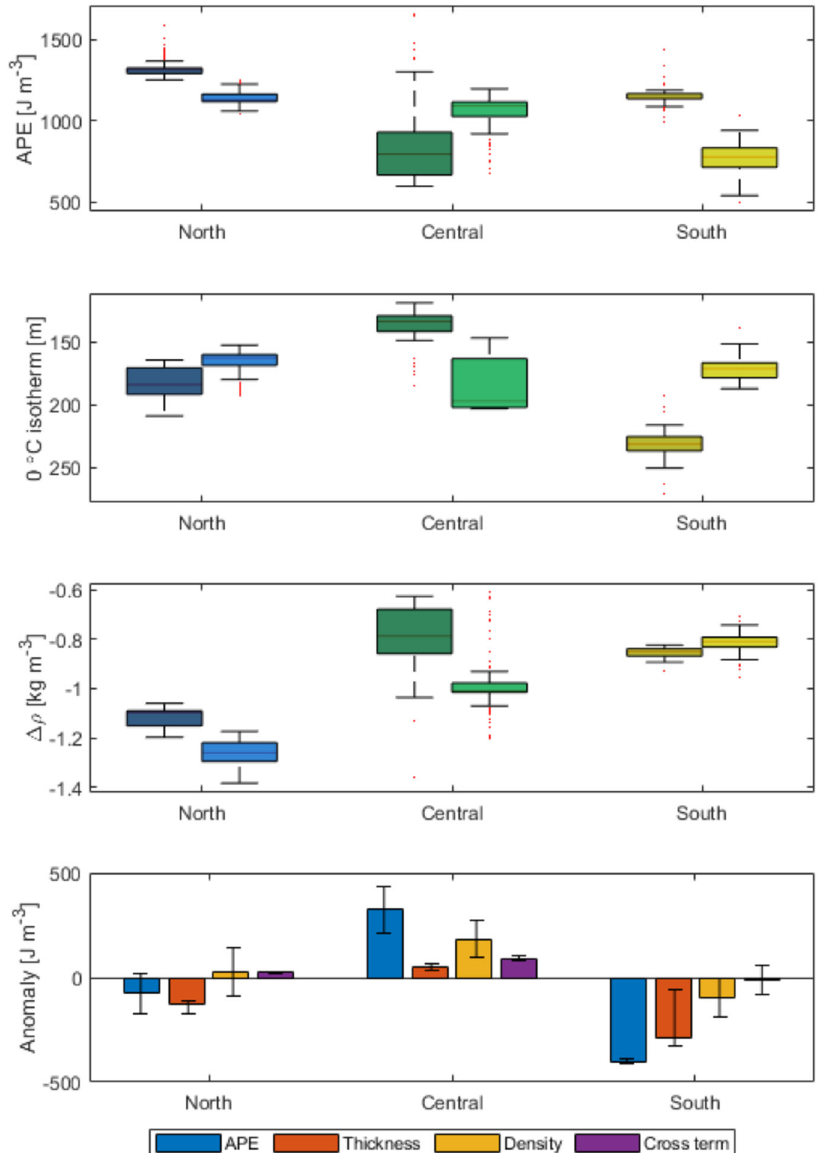
Fig. 5| Changesin Available PotentialEnergyanditsconstituents duringJuly/ August/September. Available potential energy (APE, a ), depth of the 0°C iso- therm ( b ) and mean density deviation ( Δρ ) from the surface to the depth of the 0°C isotherm ( c ) in the north (81°N – 77°N), central (77°N – 74°N), and south (72°N – 69°N) regions over the near-shore shelf. The dark and light colour shading